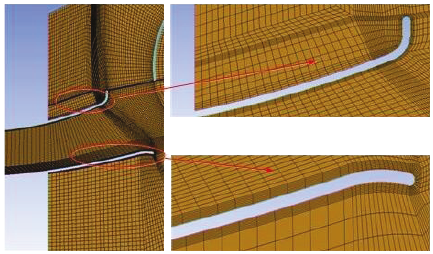
Figure 8: Sample of multiblock-structured mesh at dump